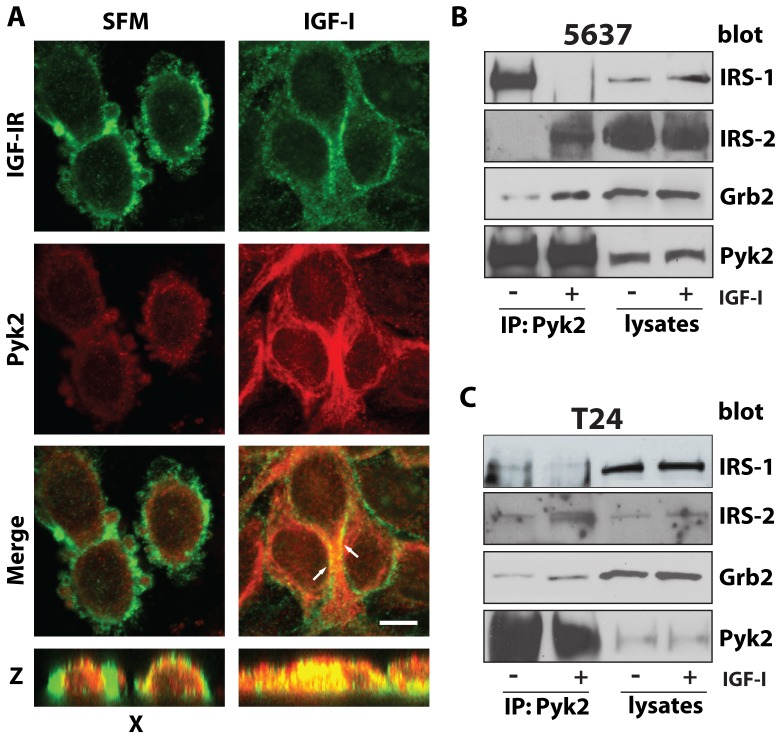
Pyk2 colocalizes with the IGF-IR and complexes with IRS-2 and Grb2 after IGF-I stimulation of urothelial cancer cells.(A) 5637 cells were serum-starved over night and then treated with 50 ng/ml of IGF-I for 30 minutes. After fixation, cells were labeled with a monoclonal anti-IGF-IR (green) and a polyclonal anti-Pyk2 (red) and imaged by confocal microscopy. The pictures of merged fields show colocalization (yellow) of IGF-IR and Pyk2 in the IGF-I treated cells (arrows) but not in unstimulated control cells. The distinct co-localization of Pyk2 and IGF-IR is detectable in the Z stacks (yellow staining, bottom panel). Pictures are representative of at least 10 independent fields from two independent experiments. An average of 300 cells was examined for each condition. Bar: 10 µm. (B) 5637 and(C) T24 bladder cancer cells were serum-starved for 24 hours and then stimulated with 50 ng/ml of IGF-I for 30 minutes. Two mg of cell lysates were immunoprecipitated with anti-Pyk2 polyclonal antibodies. IRS-1, IRS-2, Grb2 and Pyk2 levels were assessed by immunoblot with specific polyclonal antibodies. Blots are representatives of three independent experiments.